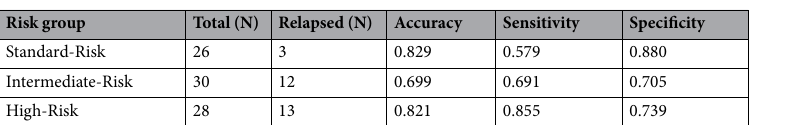
Table 3. Prediction performances on stratified risk groups of the 84